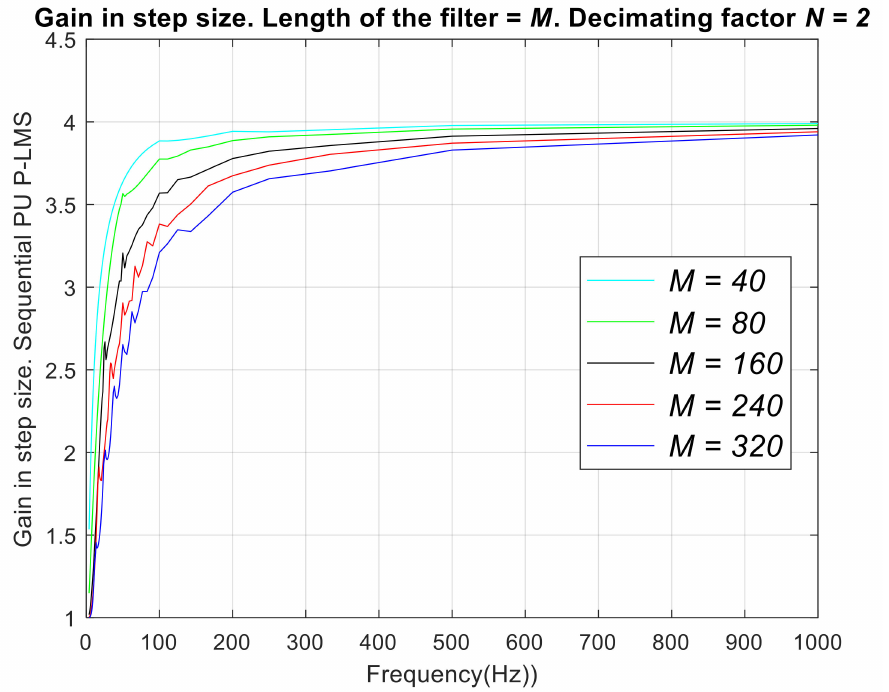
Figure 4. Gain in step-size for a single tone when using the matrix-based version (from Parra et al.) of the periodic LMS algorithm with seq. partial updates. Decimation factor is set to N = 2. The length of the filter M varies from 40 to 320